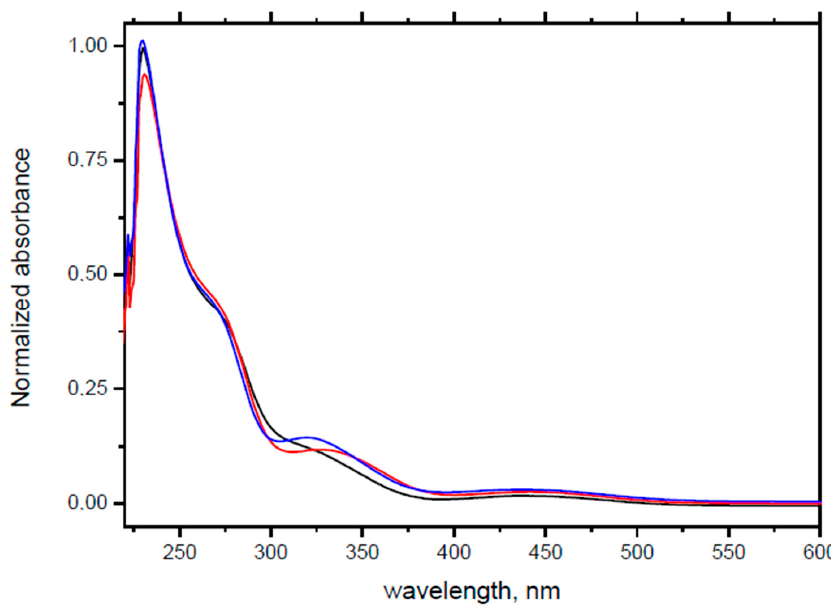
Figure 4. UV/Vis spectra of 1 (black), 2 (blue) and 3 (red) in dichloromethane, c = 10 − 5 mol/L.